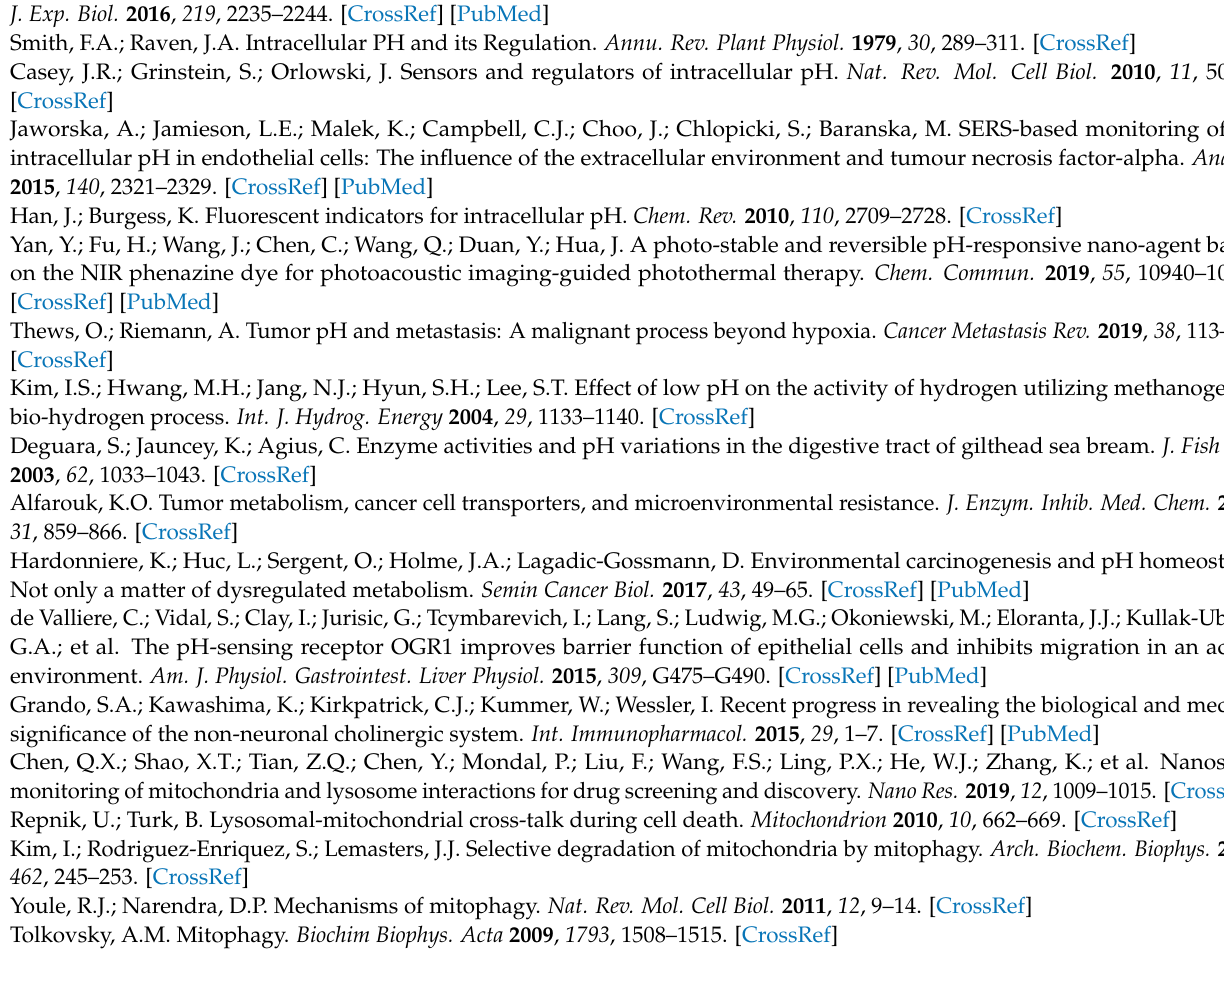
spectrum of BP; Figure S7 Plot curve of fluorescence intensity of 10 µ M probe BP versus pH. The information of the curve: Model, Boltzmann. Equation, y = A2 + (A1 − A2)/(1 + exp((x − x 0 )/dx)). pKa = x 0 ; Figure S8 Frontier molecular orbital energy diagram of BP and its opening structure BP + in a vacuum. Transition energies were calculated using the TD-B3LYP method with 6–31G basis sets; Figure S9 Viabilities of HeLa and U87 cells after incubation with different concentrations of BP for 24 h. Reference [55] are cited in the supplementary